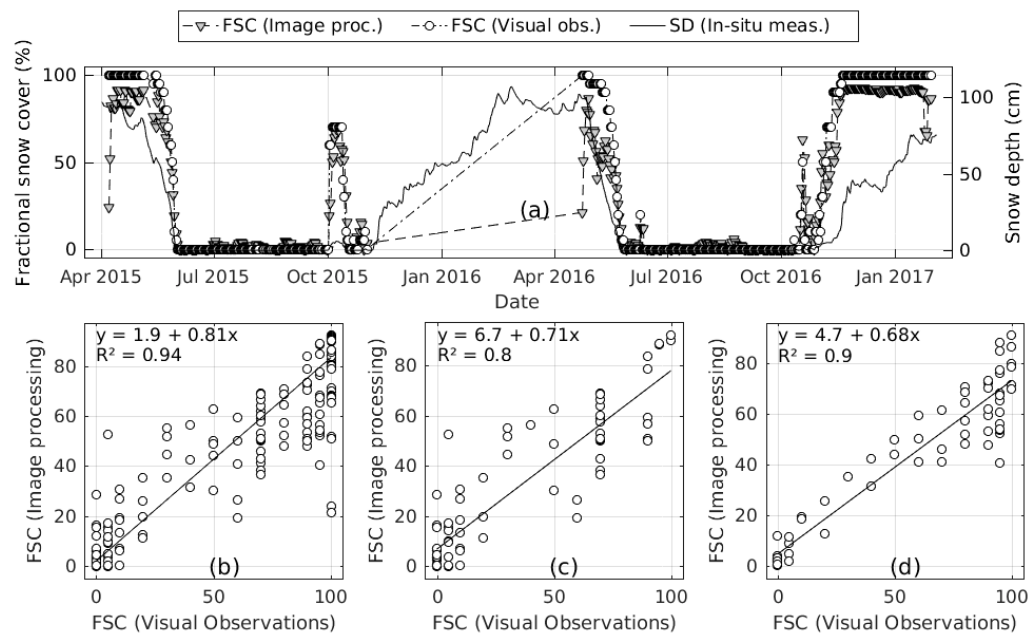
Figure 11. Kenttärova canopy camera: ( a ) 3-day moving window averaged fractional snow cover over time from image processing and daily visual observations, daily averaged snow depth over time from automatic ground measurements. Distribution and regression of fractional snow cover from image processing versus visual observations for ( b ) all data; ( c ) early season; and ( d ) melting season.